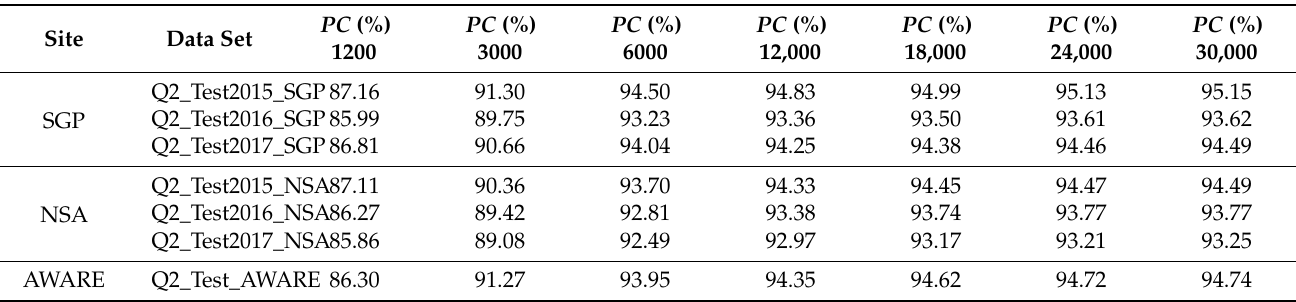
Table A1. The classification results of testing set based on the proposed algorithm under differ- ent number of samples for training. The value below PC indicates the number of samples used for